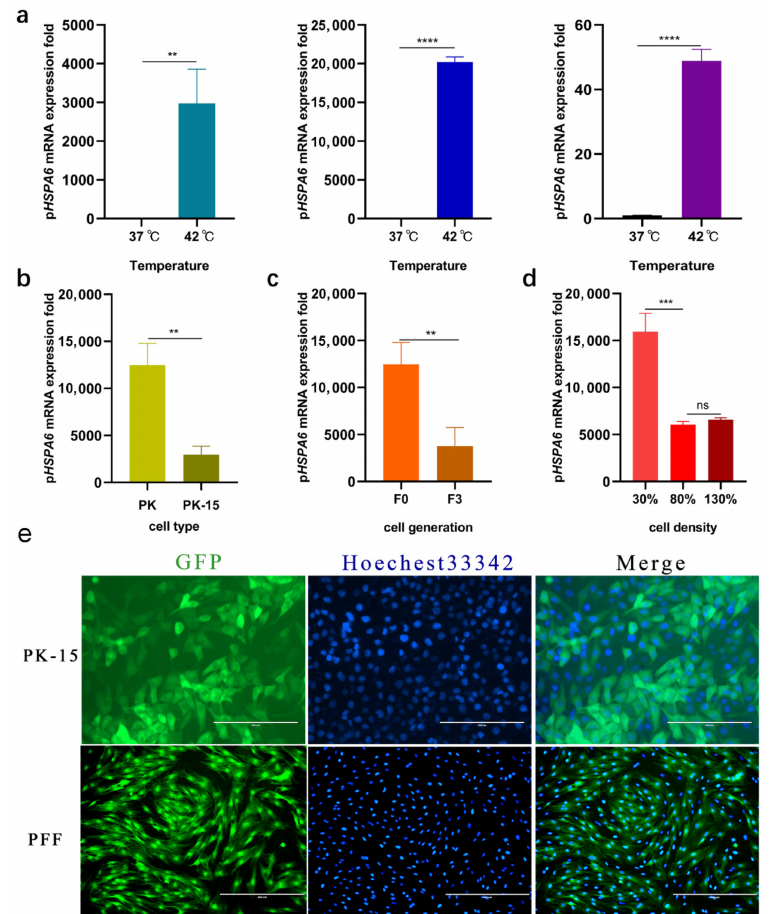
Figure 1. Analysis of the HSPA6 gene in porcine cells. ( a ) The mRNA expression of HSPA6 in PK-15, PFF, and 3D4/2 cells was detected by qPCR under heat. ** p < 0.01, **** p < 0.0001. ( b ) qPCR analysis of inducible p HSPA6 expression in PK and PK-15 cells. ** p < 0.01. ( c ) qPCR analysis of inducible p HSPA6 expression in F0 and F3 cells. ** p < 0.01. ( d ) qPCR analysis of the cell density of inducible p HSPA6 expression in PK cells. *** p < 0.001, ns = not significant. ( e ) Fluorescence microscopy analysis of the eGFP expression in PK-15 cell line and PFF cells under